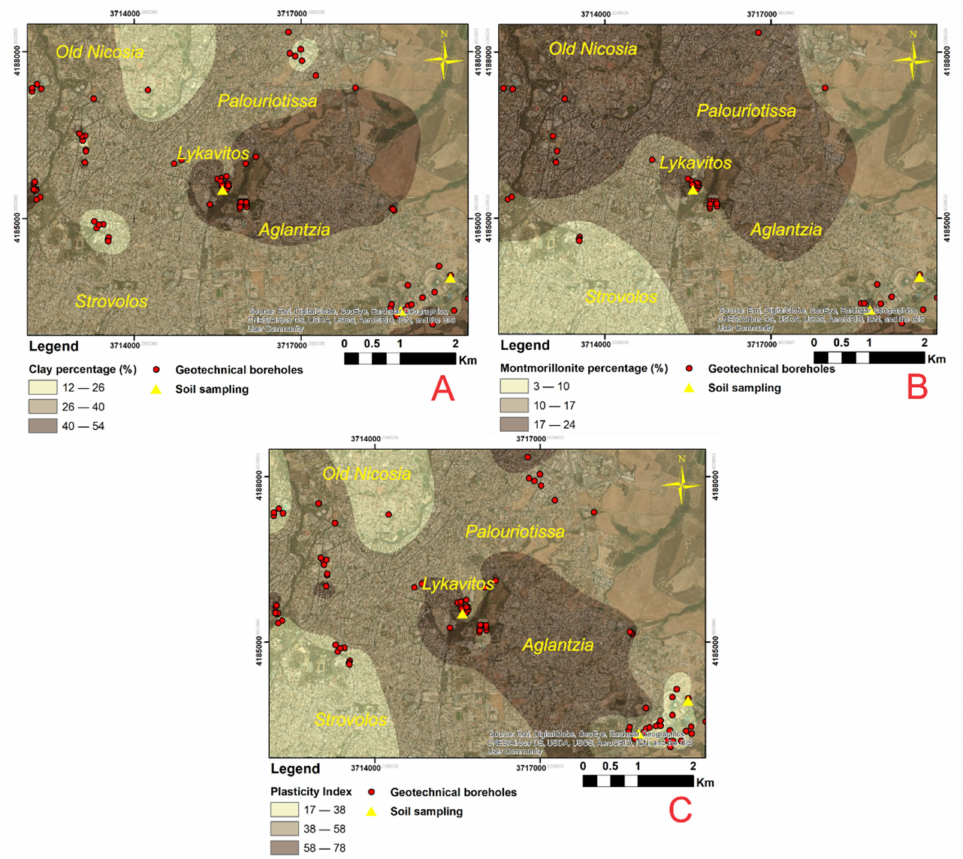
Figure 3. Thematic layers of Nicosia khaki marl geotechnical properties: ( A ) clay content (%), ( B ) montmorillonite content (%) and ( C ) plasticity